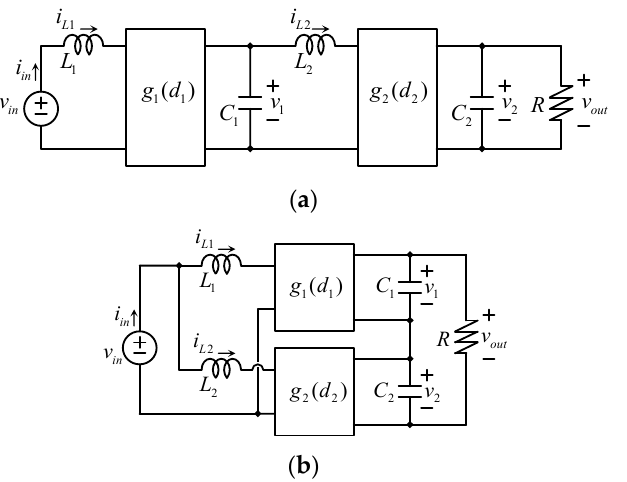
Figure 1. Two common configurations of two power cells to obtain high voltage gain: ( a ) cascaded configuration; ( b ) input-parallel output-series configuration.